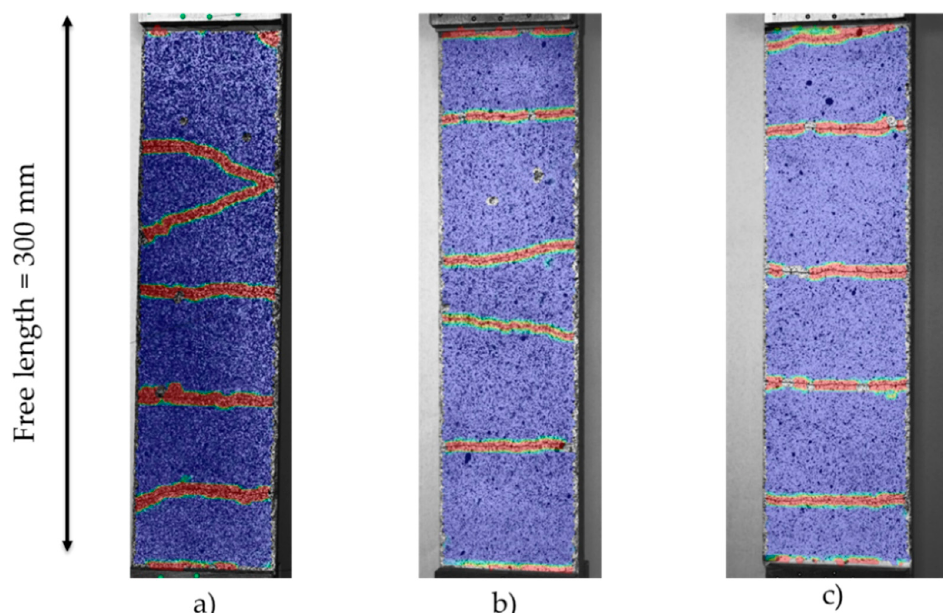
Figure 11. Crack patterns of the material combinations loaded with 140 kN/m ( a , c ) and 117 kN/m ( b ). ( a ) M1—T 1C; ( b ) M2—T 1C; ( c ) M2—T 2B. ( b ). ( a ) M1—T 1C; ( b ) M2—T 1C; ( c ) M2—T